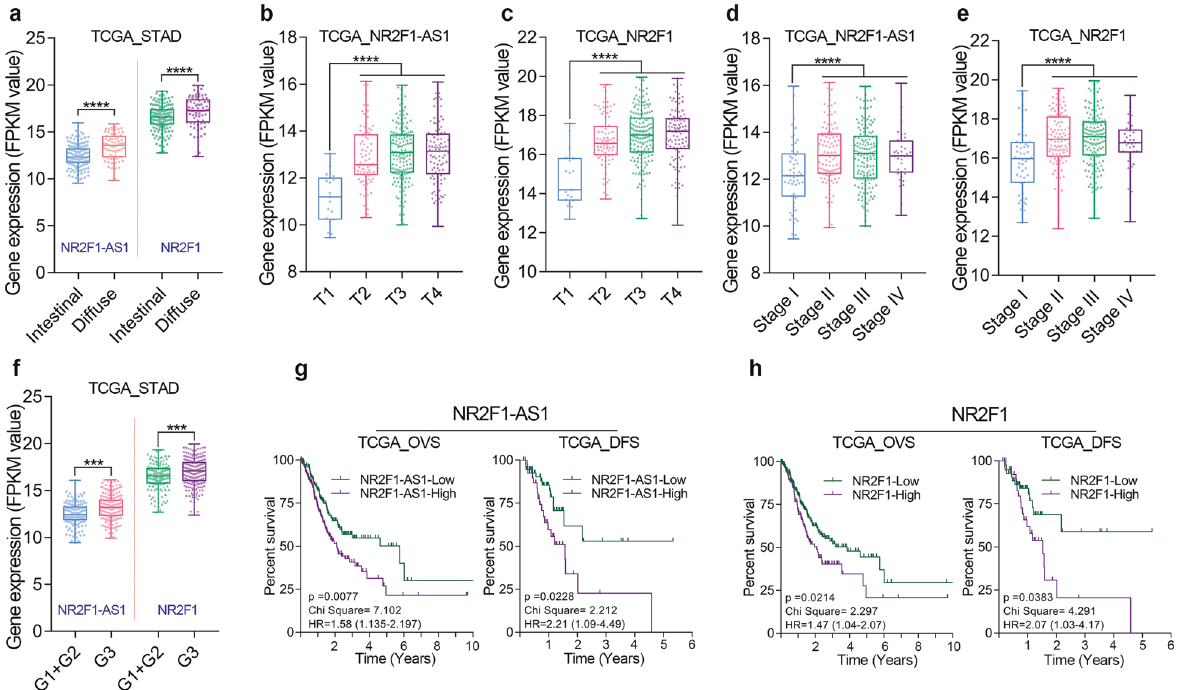
Fig. 2 The clinical signi fi cance of NR2F1-AS1 and NR2F1 was analyzed in the TCGA cohort. a Difference in expression levels of NR2F1-AS1 and NR2F1 between intestinal and diffuse GC tissues. b , c NR2F1-AS1 and NR2F1 expression level in different T-stages of GC. d , e NR2F1-AS1 and NR2F1 expression level in different Pathologic stages of GC. f Difference in expression levels of NR2F1-AS1 and NR2F1 in GC tissues with different degrees of differentiation. g , h Overexpression of NR2F1 and NR2F1-AS1 predicted poor prognosis in TCGA cohort. **** P < 0.0001; *** P < 0.001; ** P < 0.01; * P <